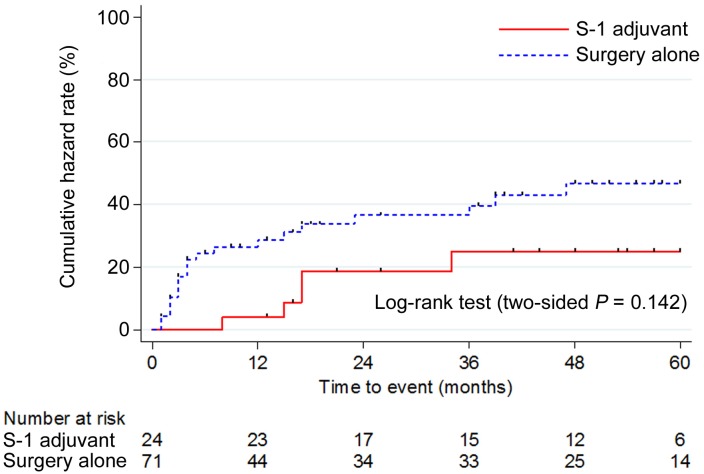
Cumulative hazard rate of the time to relapse in the overall cohort.TTR, time to relapse; OC, overall cohort.